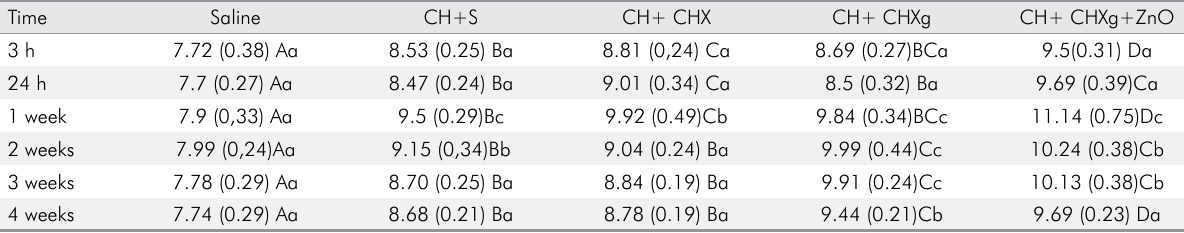
Table 2. Mean (Standard deviation) pH values for the groups at each time